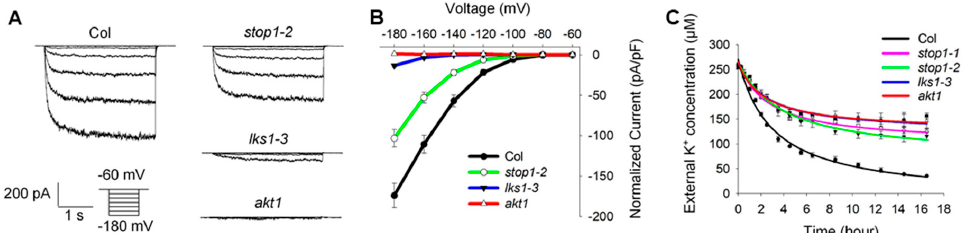
Figure 6. K + uptake is impaired in stop1 mutant. ( A ) Patch-clamp whole-cell recordings of the inward K + currents in Arabidopsis root-cell protoplasts. The plant materials used for root-cell protoplasts isolation are indicated. The voltage protocols, as well as time and current scale bars, for the recordings are shown. ( B ) I–V relationship of the steady-state whole-cell currents in root cells. The data are derived from the recordings as shown in ( A ) and are presented as means ± SE (Col, n = 61; stop1-2 , n = 51; lks1-3 , n = 51; akt1 , n = 24). ( C ) Comparison of K + uptake via K + depletion method among Col, lks1 , akt1 , and stop1 mutants. Data are shown as means ± SE ( n = 3).